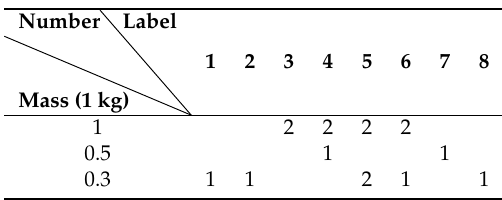
Table 3. Installation parameters of the counterweights.